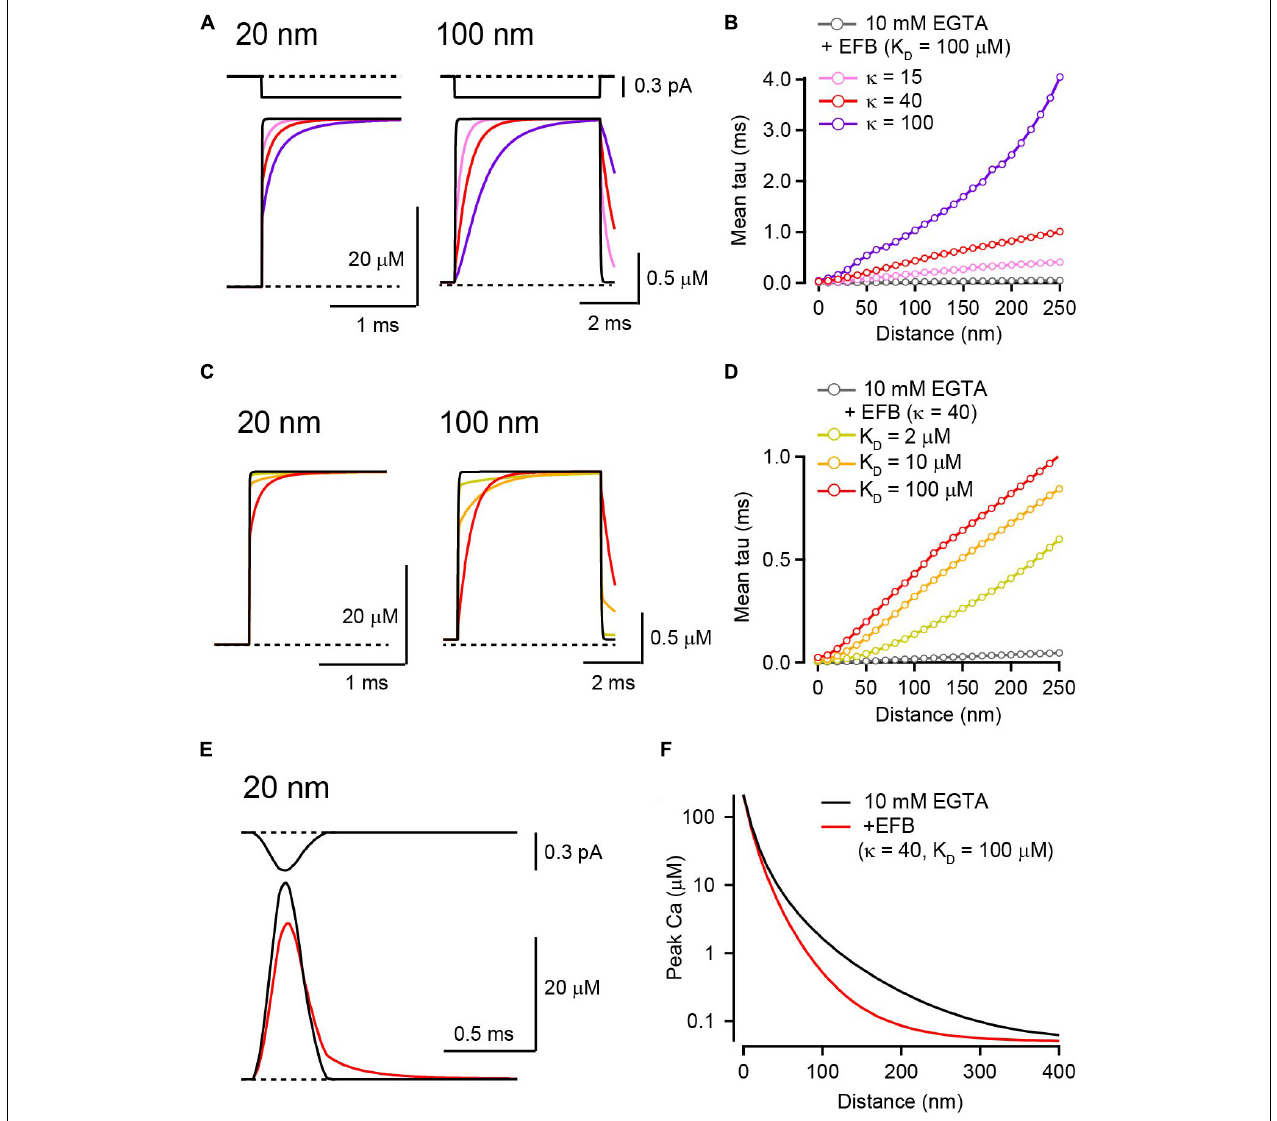
FIGURE 3 | The effect of EFB on [Ca 2 + ] transients in the presence of 10 mM EGTA. (A) Ca 2 + current through a VGCC (top) and the resultant [Ca 2 + ] i transients for 20 nm (left) and 100 nm (right) distances in the presence of EFB with various κ values. I tested κ of 15 (pink), 40 (red), and 100 (purple) by altering EFB concentration. K D was 100 µ M. (B) Mean rise times of [Ca 2 + ] transients for different EFB κ values were plotted against voxel distance. (C) [Ca 2 + ] transients for 20 nm (left) and 100 nm (right) distances with various affinities of EFB. We tested K D of 2 (yellow), 10 (orange), and 100 (red) µ M. κ was set at 40. Black and red traces are identical to those in (A) . (D) Mean rise times of [Ca 2 + ] transients for different EFB affinities. (E) Action potential-evoked [Ca 2 + ] transients 20 nm from VGCC in the absence (black) and presence (red) of EFB. The current waveform (top) was obtained from whole-presynaptic terminal Ca 2 + current at the calyx of Held evoked by action potential waveform voltage command and scaled to 0.3 pA. (F) Spatial gradients of peak [Ca 2 + ] transients evoked by an action potential in the presence of low-affinity EFB.